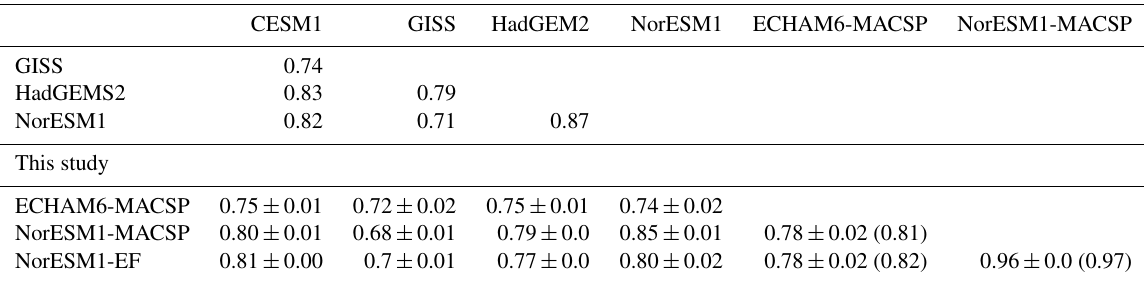
Table 3. Intermodel correlations of regional temperature response for the Samset et al. (2018) models and our models. The average correlation coefficient between the Samset et al. (2018) models is 0 . 79 with a standard deviation of 0 . 05; the average correlation coefficient between the models used in this study and the Samset et al. (2018) models is 0 . 76. The correlations are calculated for 50 years with and 50 years without anthropogenic aerosols. Correlation for our whole dataset (60 + 120 years) is shown in brackets. The range is the standard deviation between results obtained for two different CTRL runs.